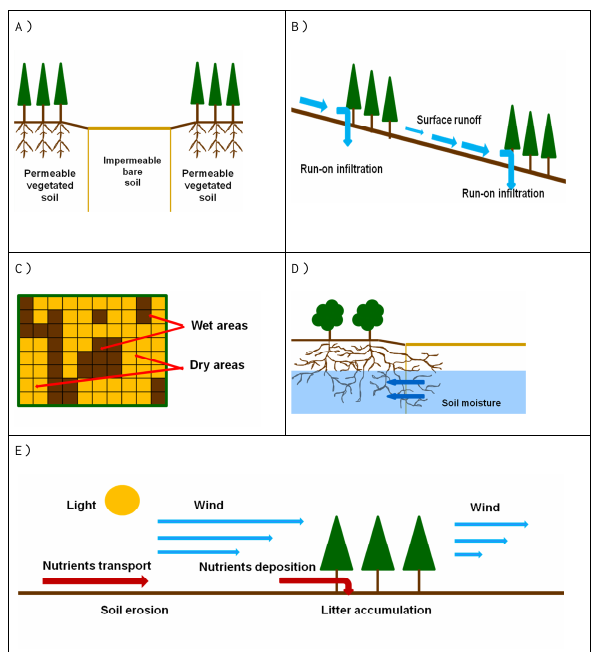
Fig. 4. (A) , (B) , (C) Aerial photographs of natural patterns (Tiger Bushes) in Niger (13 ◦ 20 0 N, 2 ◦ 04 0 E). (D) , (E) , (F) Digitized rep- resentation of the vegetation covers of the natural patterns corre- sponding respectively to (A) , (B) and (C) . (G) , (H) , (I) Simulated